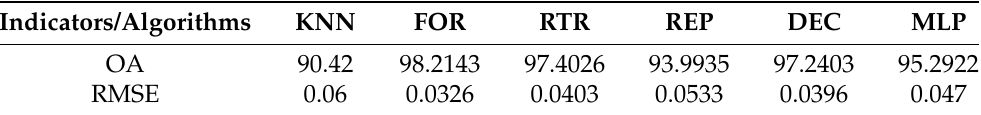
Table 4. The efficiency indicator results of each algorithm used during model